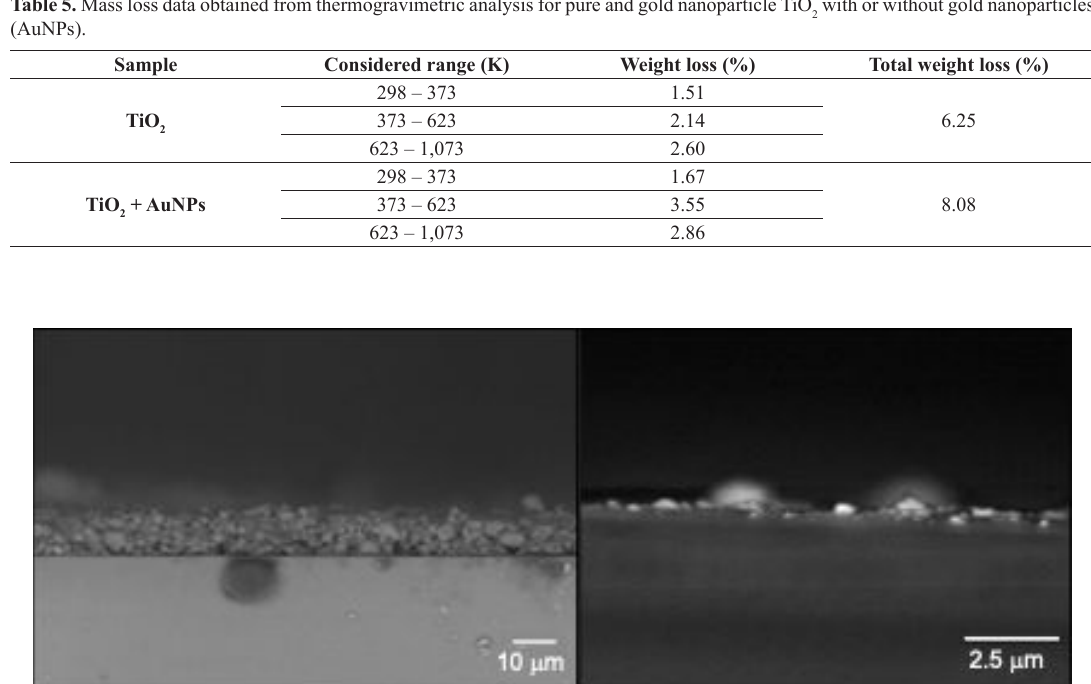
with or without gold nanoparticles 2